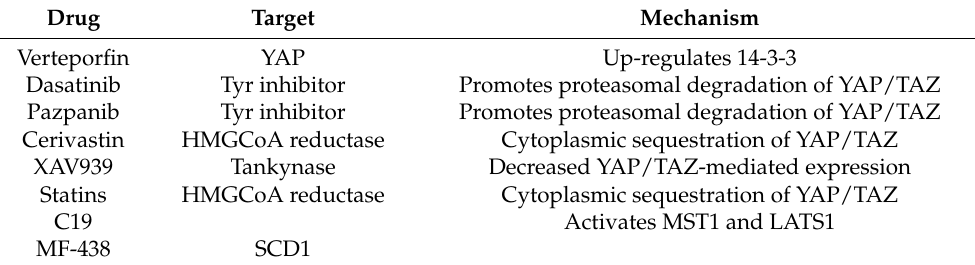
Figure 3. Potential therapeutic targets to reactivate the Hippo pathway. Modulation of upstream kinases STK3/4 and LATS1/2 occurs via post-translational modifications and transcriptional regulation. In cancer, a number of these molecules responsible for this regulation are altered. Molecules can be mutated (orange), overexpressed (red) or lost (grey) to result in high turnover or transcriptional silencing. This turns off the Hippo signalling cascade, allowing effector proteins, YAP/TAZ, to enter the nucleus and activate gene transcription, resulting in higher cell proliferation, cell cycle modulation, expression of other oncogenes such as c-Myc and AR and prevention of apoptosis, to name but a few processes. Table 1. Therapies which down-regulate YAP/TAZ